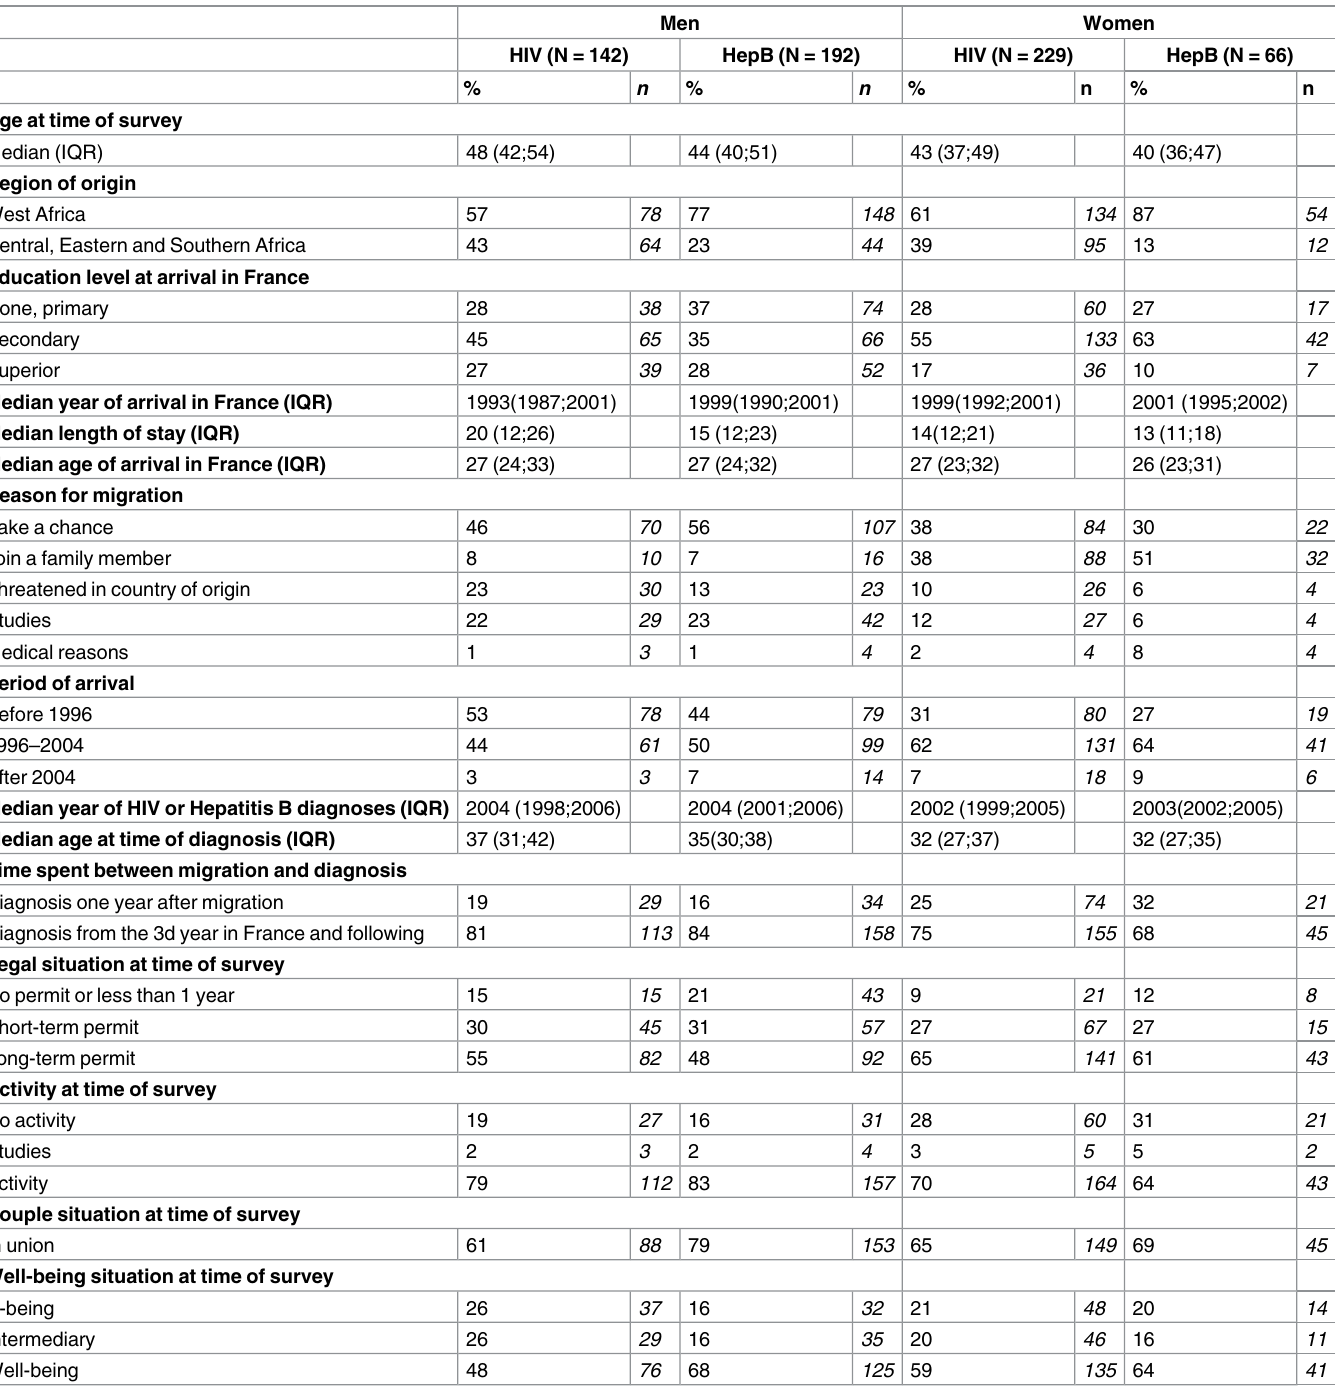
Table 1. Socio-demographic characteristics of the studied population at arrival in France and at time of